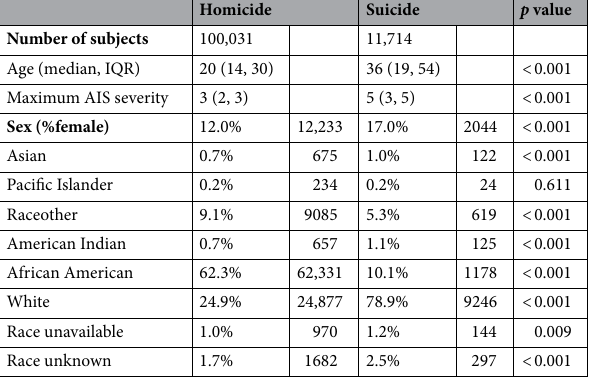
Table 1. Demographics about subjects included in the study. The percent and number of subjects in each category are provided, and for age and maximum severity, the median and interquartile range (IQR) are reported for each group.